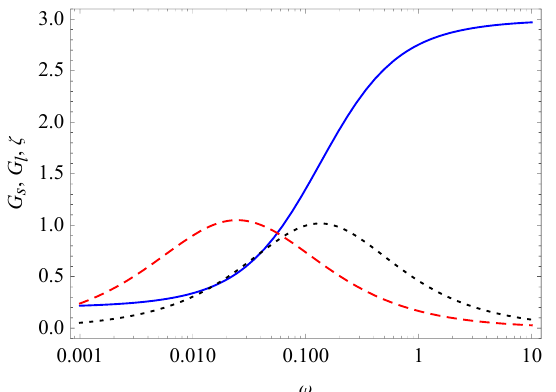
Figure 2. Curves of G s (solid line), G l (dotted line), and ζ (dashed line) versus ω for a = 5, b 0 = 0.2, b 1 = 15, and α = 0.8 in the fractional Zener model